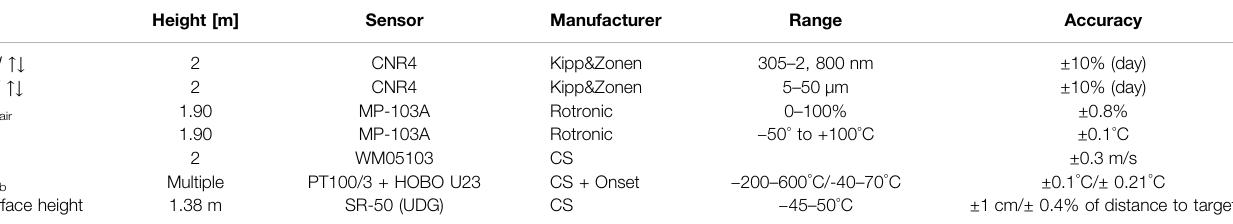
Surface height 1.38 m ± 1 cm/ ± 0.4% of distance to target CS stands for Campbell Scienti fi c; UDG stands for ultrasonic depth